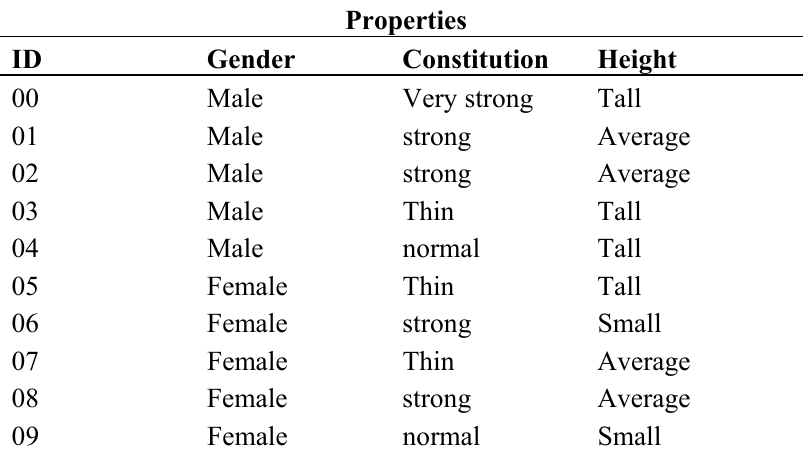
Table 2. Morphological